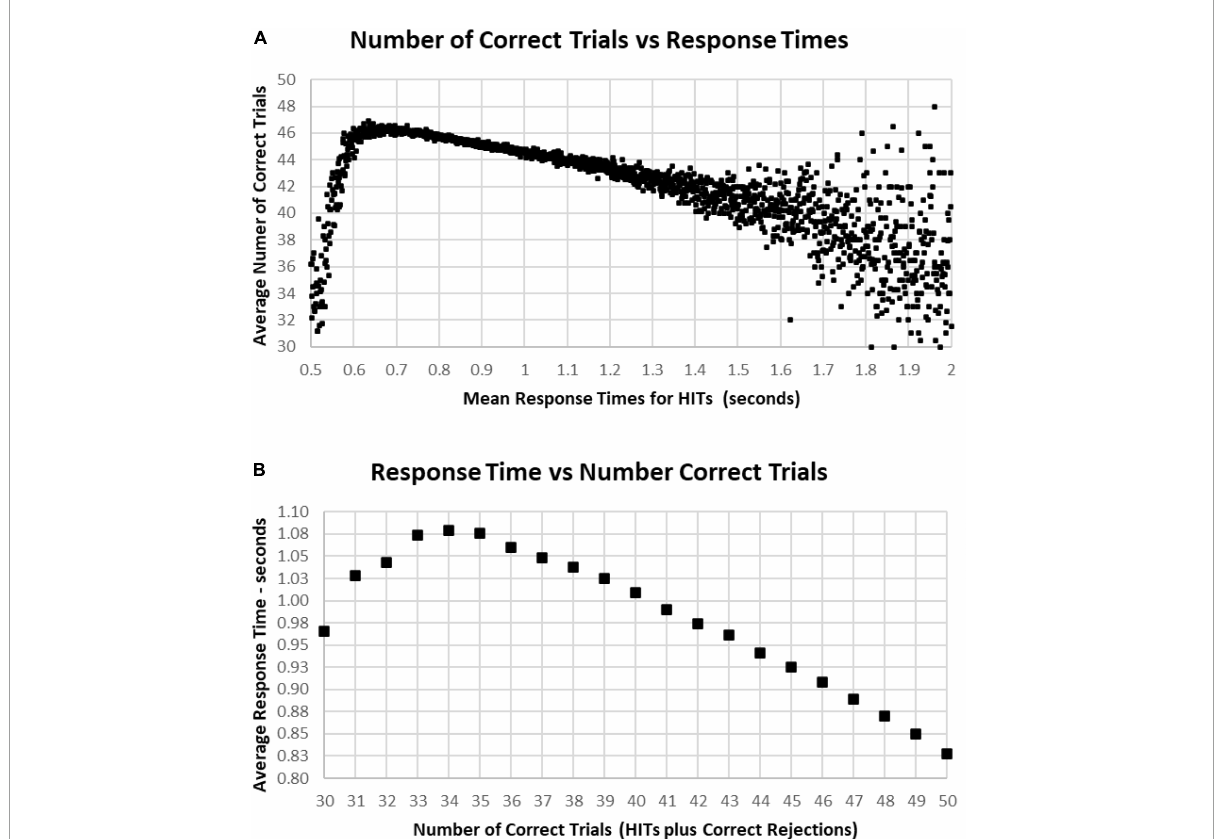
FIGURE10 (A) Average number of correct responses for each RT. The most correct responses occurred at an RT of about 0.650 s with about 46 correct (90%). The average number correct fell sharply with faster RTs and more slowly with slower RTs, until an increased variability is seen, largely due to the smaller number of subjects with RTs slower than 1.4 s. (B) Again, same data averaging RT by number of correct responses. Note that 100% correct (50 correct responses) is associated with an RT of 0.828 s. With a decreased number of correct responses, there is a progressive slowing of RT until an RT of 1.079 s at 34 correct (68%), but lower numbers of correct responses again show the discordance of RTs and performance with poorer levels of